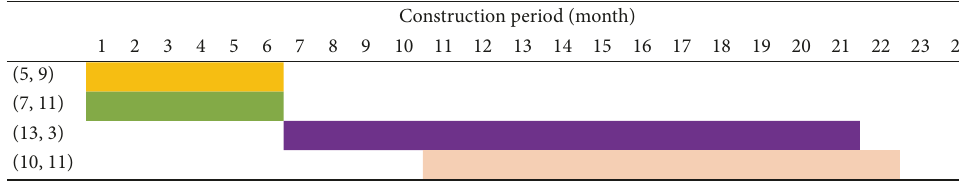
Figure 8: Selection and scheduling results with joint optimization for Scenario 2 .